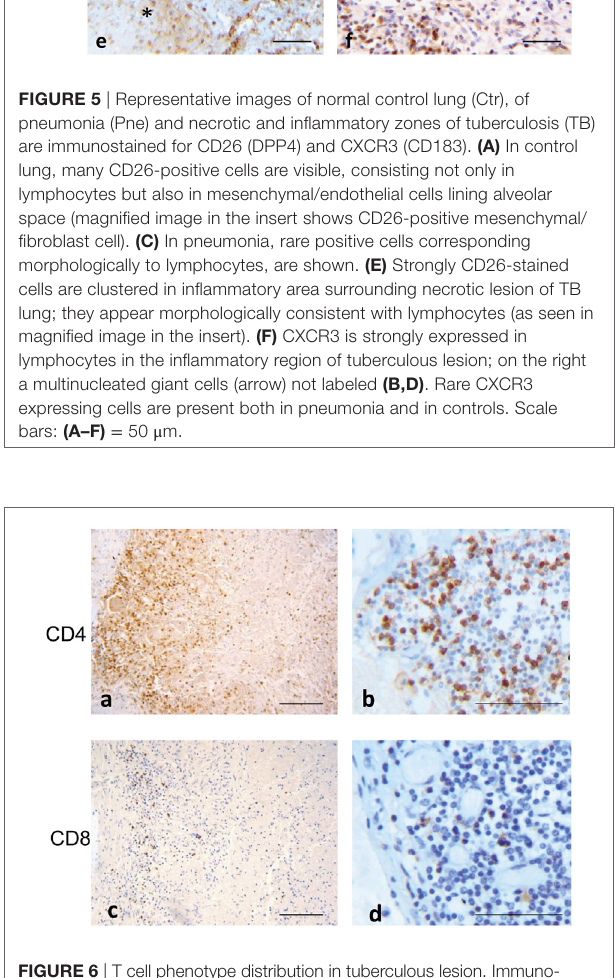
FigUre 6 | T cell phenotype distribution in tuberculous lesion. Immuno- staining with anti-CD4 (a,B) : low and high magnification and anti-CD8 (c,D) : low and high magnification show a prevalence of CD4 T lymphocytes. Scale bars: (a,c) = 100 μ m; (B,D) = 50 μ m.